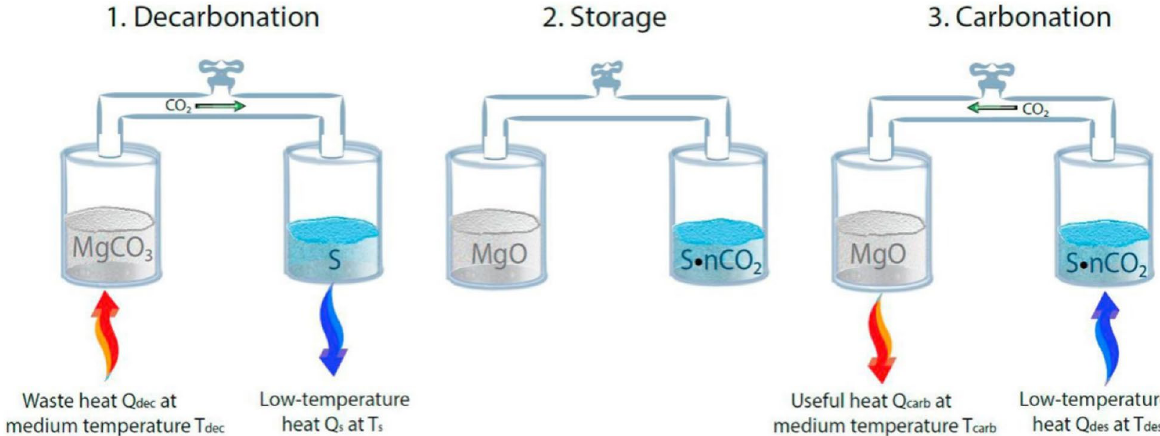
Fig. 12 An operation scheme of a chemical heat pump (heat storage mode) utilizing the MgO-CO 2 working pair